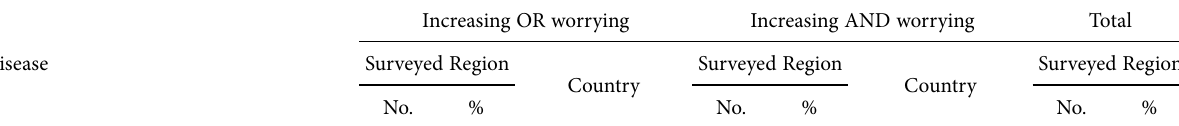
Table 7. Number of the surveyed regions in European and Mediterranean countries where alarming situations of GTD spread was reported.